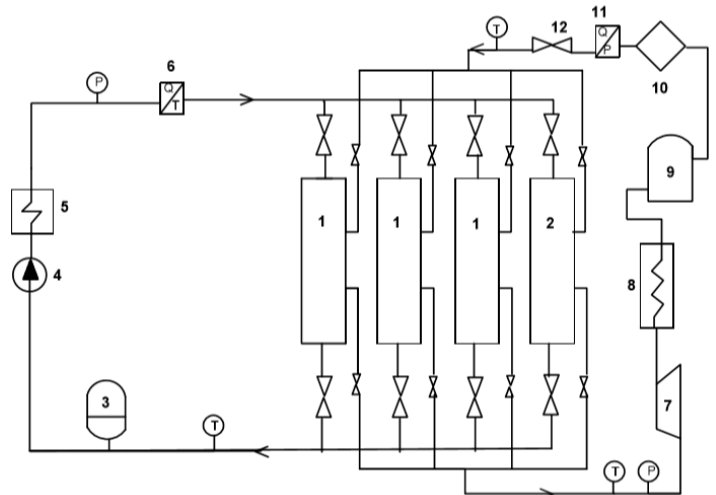
Figure 1. Experimental test bench: 1, heat exchangers with porous metals; 2, heat exchanger without porous metals; 3, expansion tank; 4, pump; 5, hot water boiler; 6, control and measuring device; 7, compressor; 8, condenser; 9, receiver; 10, filter moisture separator; 11, control and measuring device; 12, throttle; P is pressure; T is temperature; G is coolant flow rate.